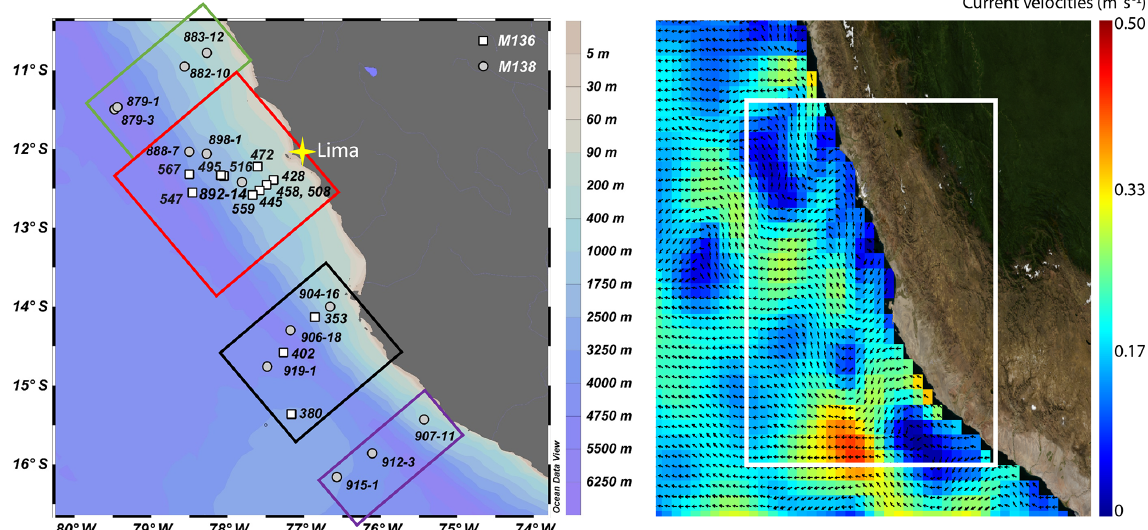
Figure 1. Maps showing (a) locations of each station from M136 (white squares) and M138 (grey circles) and (b) monthly-averaged cur- rent field in the top 15m from 16 April to 15 May 2017 derived from altimetry measurements (http://marine.copernicus.eu/, last access: 8 June 2020; product ID: MULTIOBS_GLO-PHY_REP_015_004). Color boxes in (a) schematically divide the four shelf–offshore tran- sects. Map (a) was created with Ocean Data View (Schlitzer, 2014). The white box in (b) highlights our study